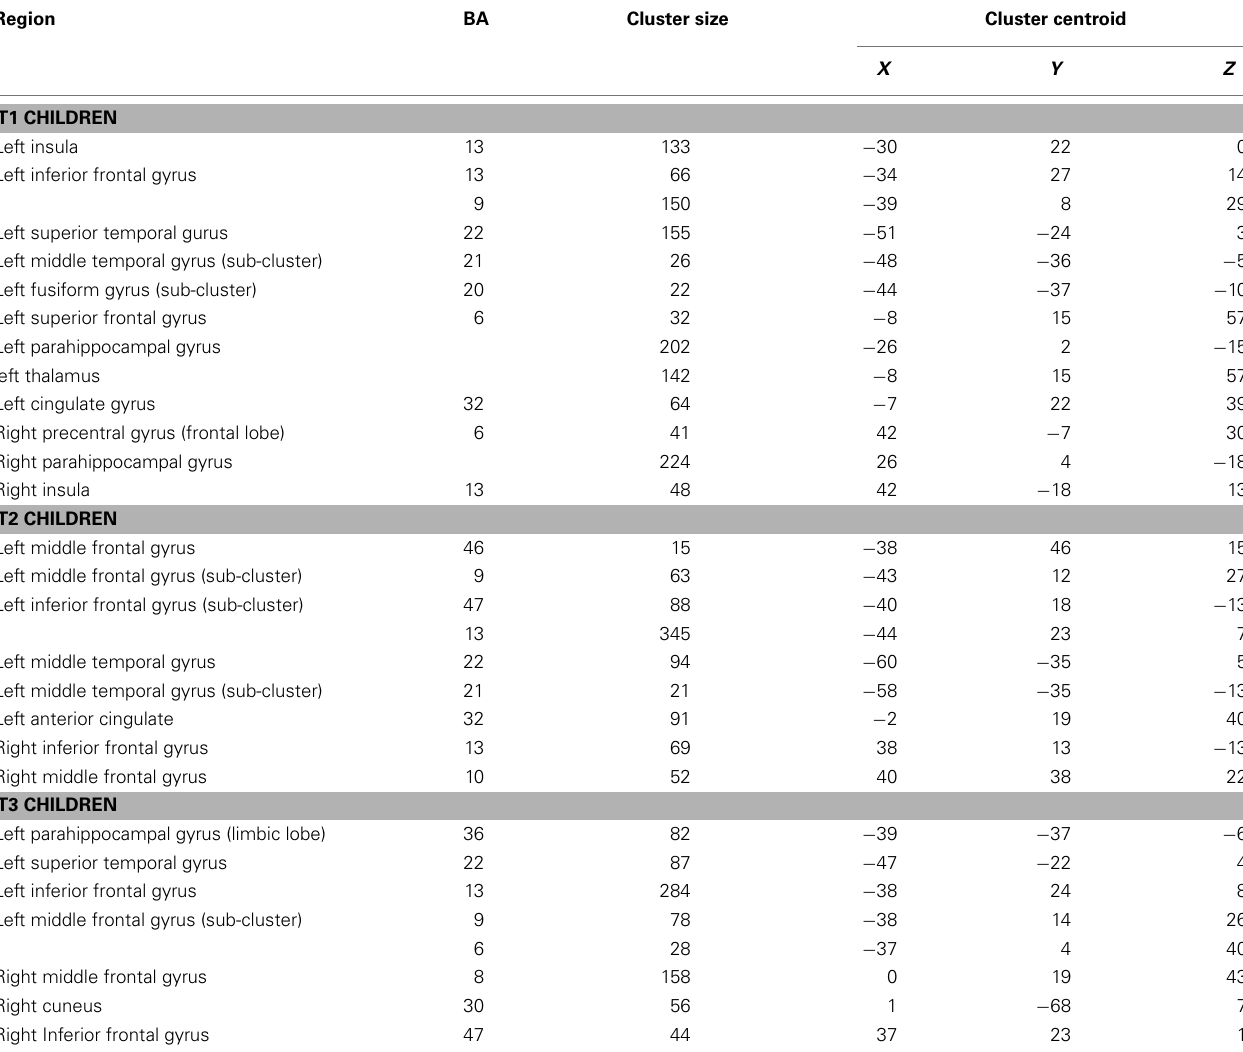
Table 1 | Group composite contrast (verb generation > finger tapping) inT1,T2, andT3 participants . Region BA Cluster